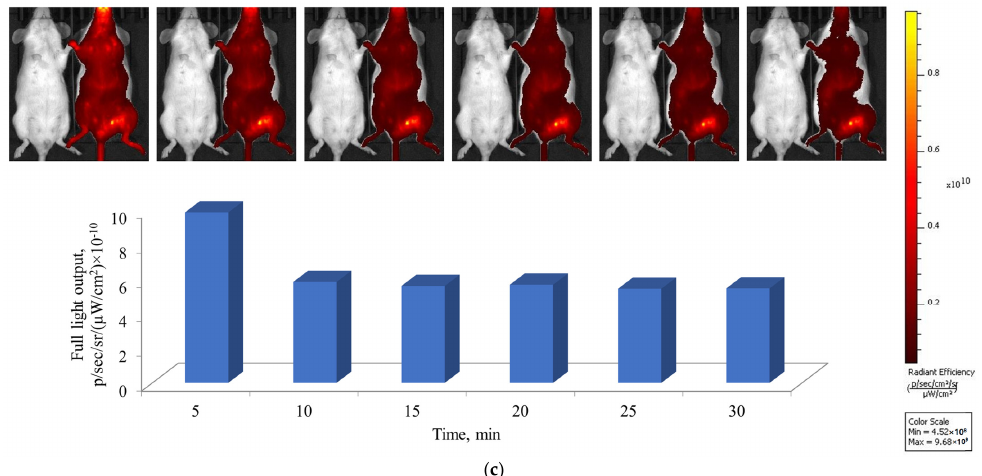
Figure 5. Fluorescent properties of magnetic liposomes with a fluorophore: ( a ) in vitro fluorescence study; ( b ) 3D reconstruction of the area of magnet implantation and the fluorescence zone; ( c ) dis- tribution of fluorescence in time in the area of action of the magnetic field and changes in fluores- cence intensity in the zone of action of the magnetic field over the period of 30 min after intravenous administration. The order of images corresponds to 5, 10, 15, 20, 25, and 30 min post-injection. To monitor the accumulation of MLPSICG in the zone of action of the magnetic field, a permanent magnet was implanted in the soft tissues of the hip, as shown in Figure 5b. After intravenous administration of MLPSICG, their accumulation was observed in the zone of action of the magnetic field of a permanent magnet (Figure 5c). The maximal level of fluorescence was observed 5 min after injection. Starting from the 10 th min post-injec- tion, the value of fluorescence remained at a relatively stable level. This might be at- tributed to the process of rapid MLPSICG destruction taking place during the first 5–10 min after administration and accumulation. It is conceivable that the remaining part of intact MLPSICG accumulated in the area of interest provides a stable level of fluorescence in a prolonged manner, until the process of MLPSICG stepwise biodegradation starts. MLPSICG biodistribution was studied at 30 min after their intravenous administra- tion in the same animals by means of registering the NIR fluorescence intensity in the main organs (Table 2, Figure 6). Compared with controls, the greatest level of fluorescence was observed in the liver, which is indicative of the pronounced liver accumulation of MLPSICG. This is consistent with previous studies on the biodistribution of lipid-based ICG-incorporating nanoparticles [48,49]. The liver is considered to be the main organ of the reticuloendothelial system, with the Kupffer cells being responsible for the recognition of opsonized foreign particles and their phagocytosis [50]. A moderate but significant ac- cumulation of MLPSICG was also observed in the lung and spleen which represent sec- ondary organs of the reticuloendothelial system owing to the activity of alveolar and splenic macrophages, respectively. The significant elevation of fluorescence intensity in the kidney might point to the renal excretion pathway of MLPSICG. There was no accu- mulation of MLPSICG in the heart, possibly due to the low number of cardiac macro- phages and the strong barrier function of cardiac capillaries.